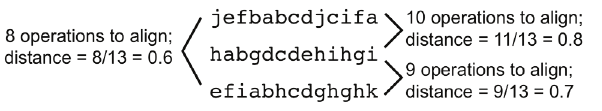
Figure 3. Three strings representing the three 10-second regionalized fixation sequences shown in Figure 5 compared for similarity using Levenshtein distance; the minimum number of editing operations required to align one string with another is divided by the length of the strings; an outcome of 1 would indicate maximally different strings and 0 identical